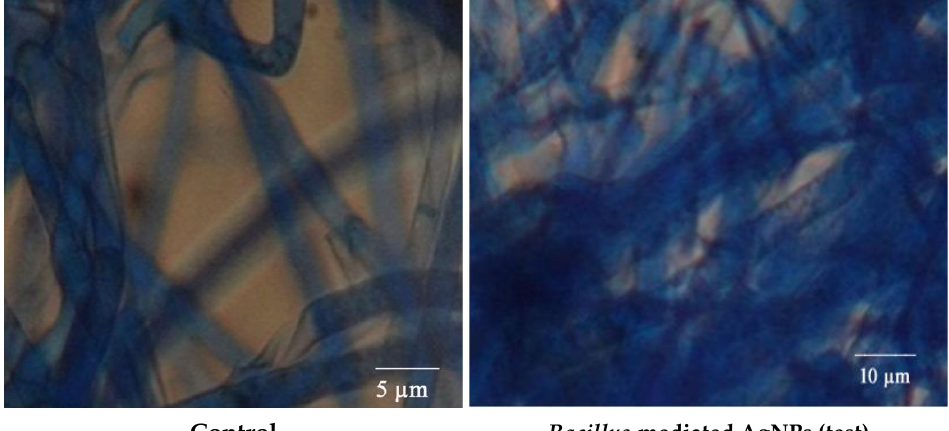
Figure 12. Fungal activity study by a compound microscope.